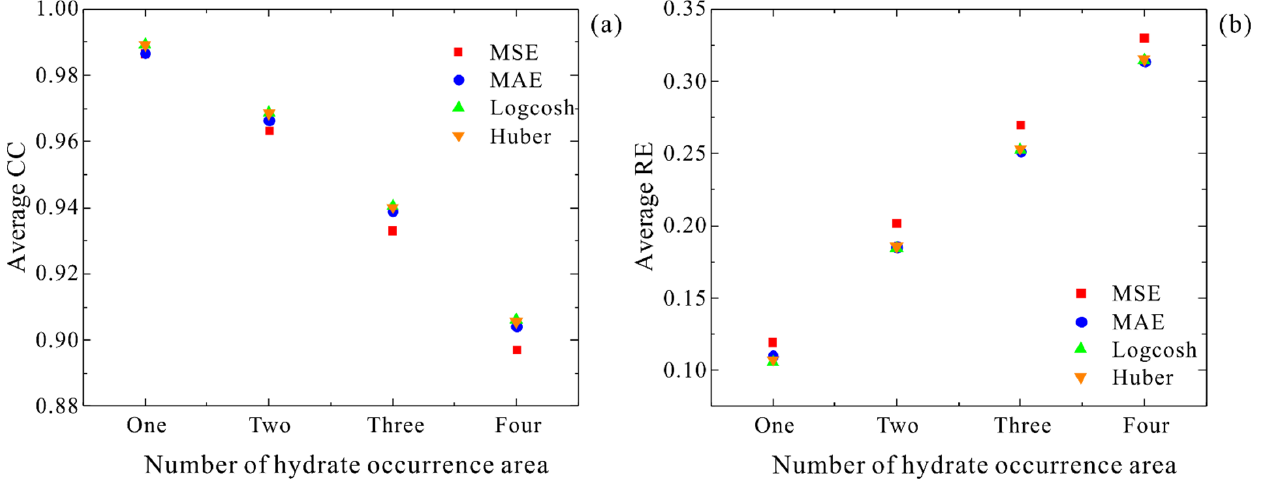
Figure 7. The average RE and CC of different samples in the test set for different loss functions. ( a ) average CC, ( b ) average RE.